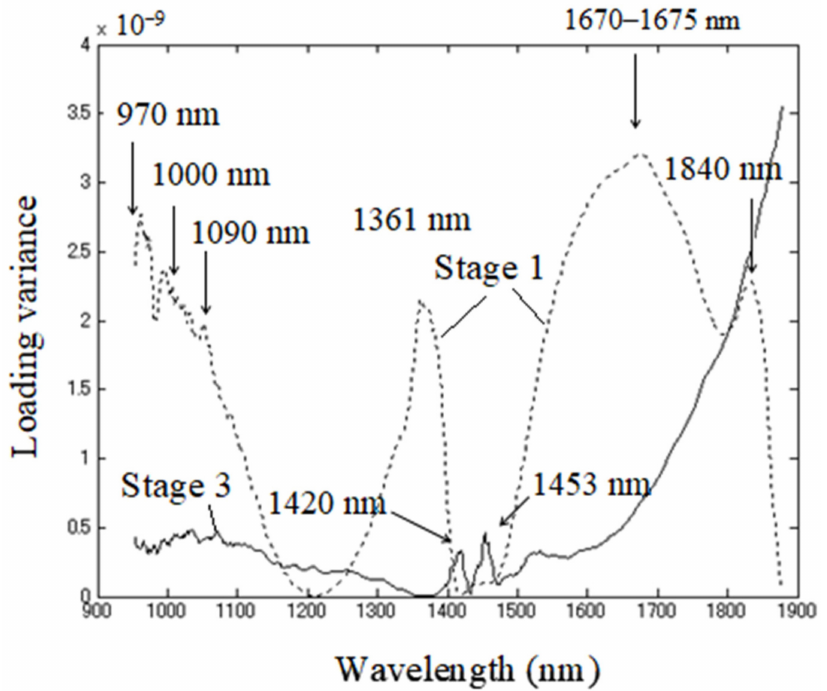
Figure 6. Loading variance for stage one (the period from the beginning of fermentation—0 h until 3 h and 15 min of fermentation) and stage three (from 4 h 30 min after the beginning of fermentation until the end of monitoring, 8h